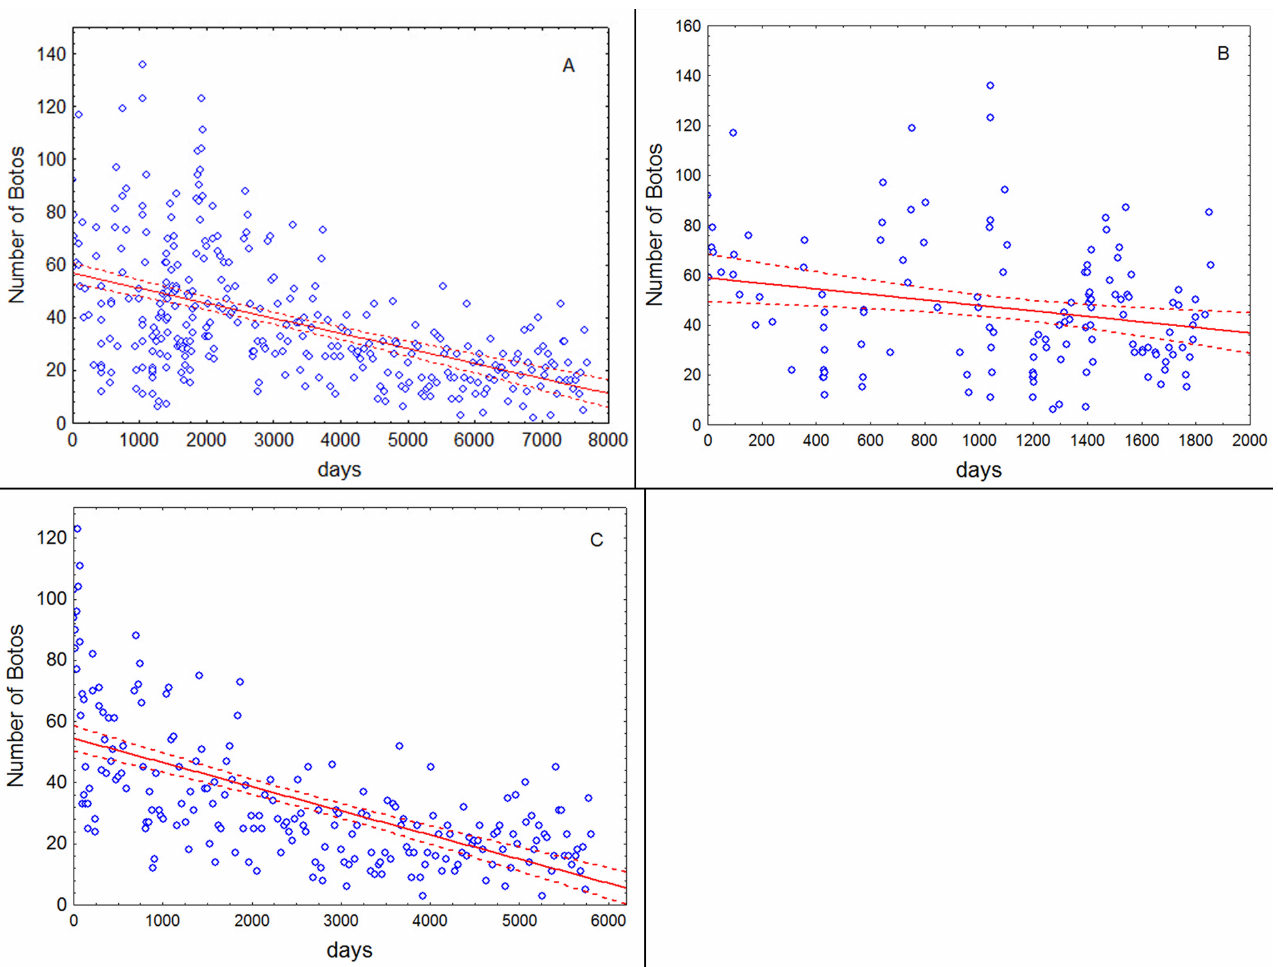
Fig 2. Scatterplots of the number of observed botos per survey as a function of time, including the trend line and 95% confidence intervals estimated by the model. (A) Entire study (Nov 1994—Jan 2017); (B) Nov 1994—Dec 1999; (C) Jan 2000—Jan